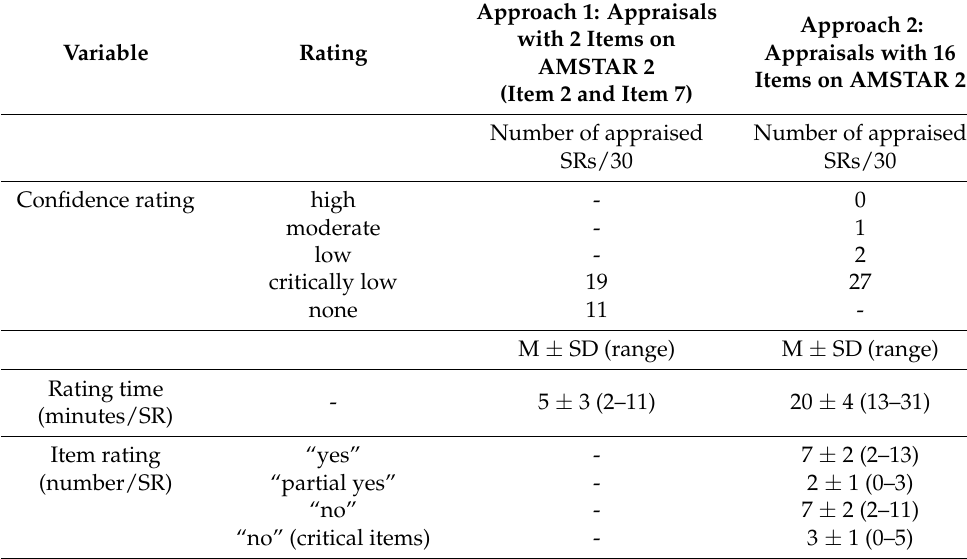
Table 2. SR appraisals with AMSTAR 2 using two